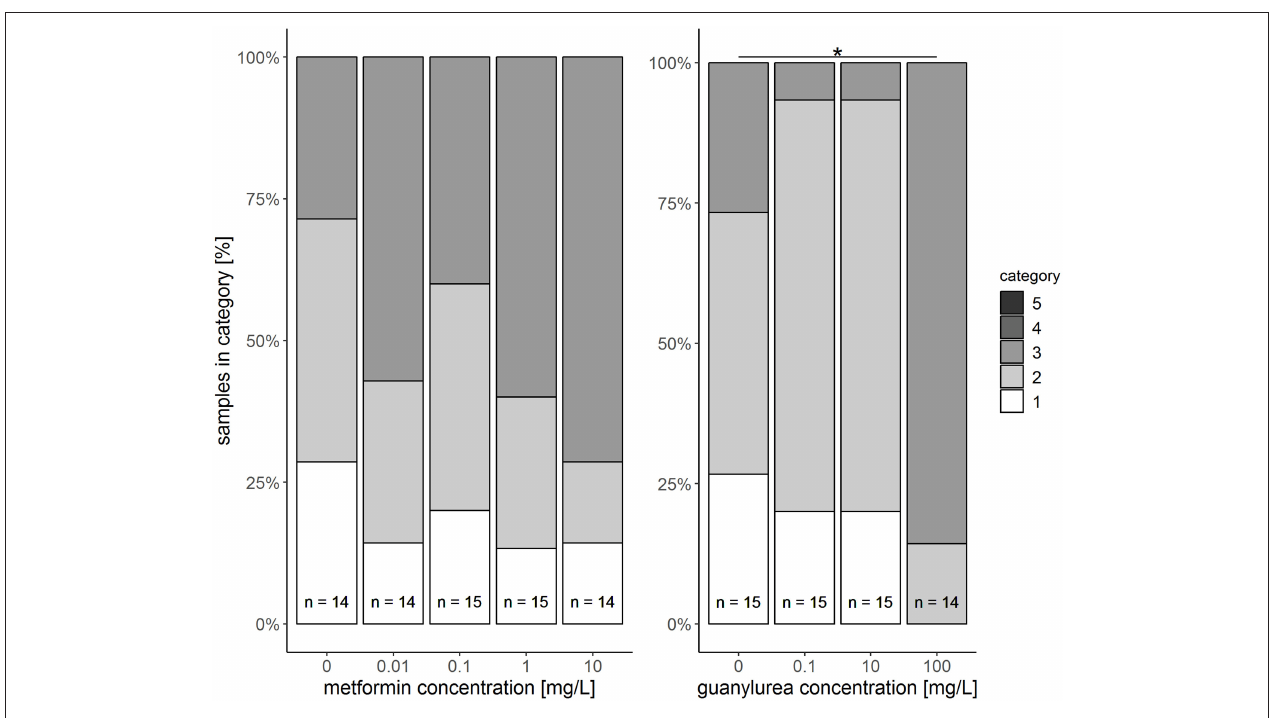
FIGURE 2 | Semi-quantitative assessment of histopathological symptoms in the hepatopancreas of big ramshorn snails exposed to metformin and guanylurea. Samples were classified in category 1 to 5. Categories 4 and 5 were not allocated to any of the samples. The number n of examined individuals is given at the bases of the bars. The asterisk indicates a significant difference compared to the respective control at the α = 0.05